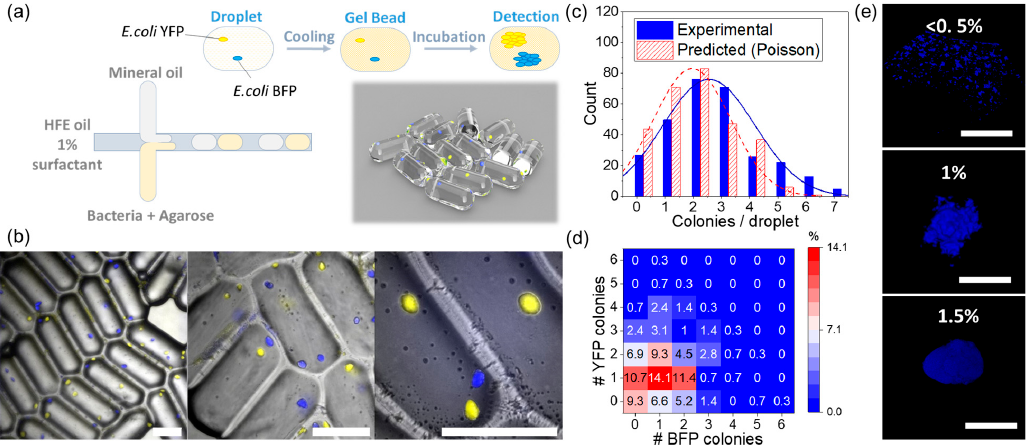
Figure 1. Agarose microbeads as mini-Petri dishes for bacterial co-cultivation study ( a ) Concept illustration of the generation of the agarose microbeads for bacteria co-cultivation. Droplets of liquid agarose mixed with one or two types of bacteria were generated using a millifluidic system. The agarose crosslinks at low temperature and turns droplets into gel beads immobilizing the contained bacteria. ( b ) Overlap images of brightfield and 2-fluorescence-channel of E. coli BFP and E. coli YFP colonies in gel beads after 12 h of incubation at different magnification (left to right: 2.5 × , 5 × , 10 × ). The scale bars represent 500 µ m. ( c ) Histogram of bacterial colony number distribution per microbead (droplet) in experimental data and predicted Poisson distribution, showing the number of bacterial colonies per microbead matched the predicated Poisson distribution at an inoculum of 2 cells/microbead. ( d ) Distribution of E. coli YFP and E. coli BFP colonies in microbeads at an inoculation ratio of 1:1 and an inoculum size of 2 cells/microbead. The color scale from blue to red represents the probability of having a specific colony number of BFP (0–6) or YFP (0–6) cases in the bead, e.g., the statistical probability of having one BFP and one YFP is 14.1%. ( e ) Confocal microscope images of E. coli BFP in gel bead at different agarose concentrations (scale bar: 100 µ